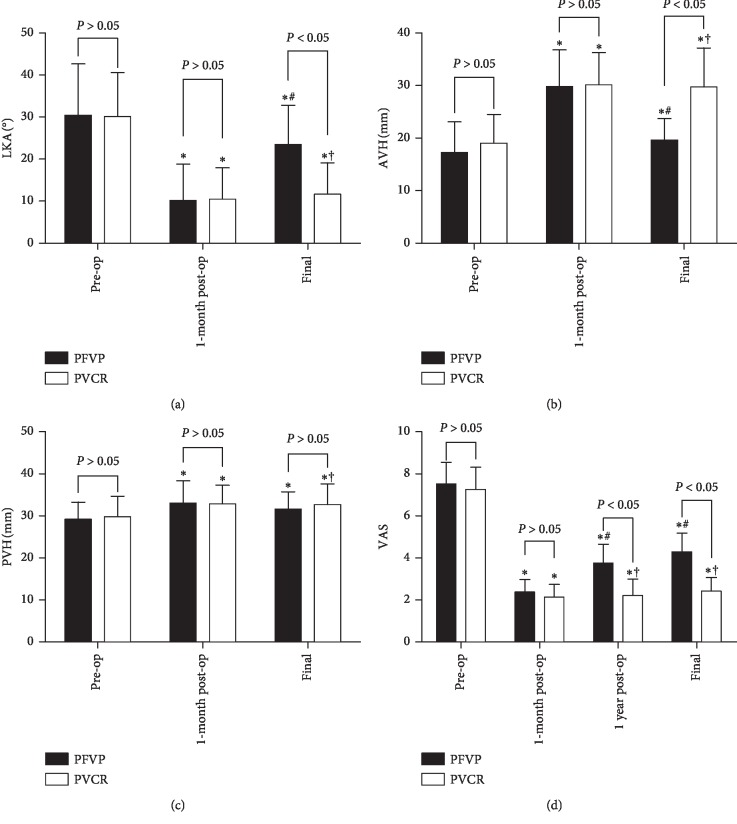
Radiological outcomes and VAS scores. (a–d) ∗P < 0.05 compared with the preoperative data. #P < 0.05 compared with the 1-month postoperative data. †P > 0.05 compared with the 1-month postoperative data.